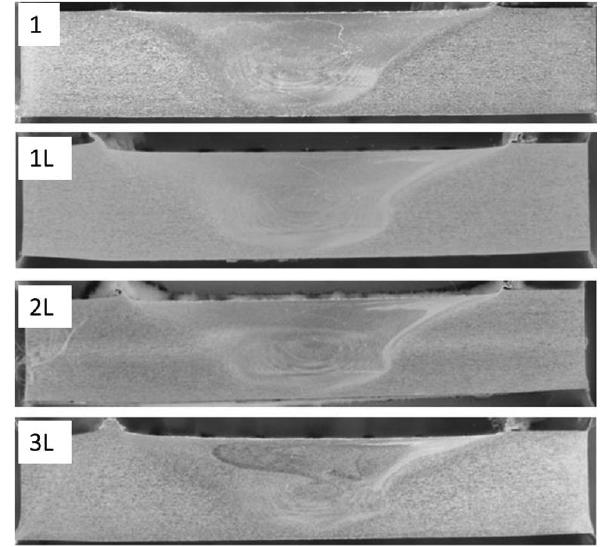
Figure 6. Macrographs of FSW and LAFSW showing the advancing side on the right and the retreating side on the